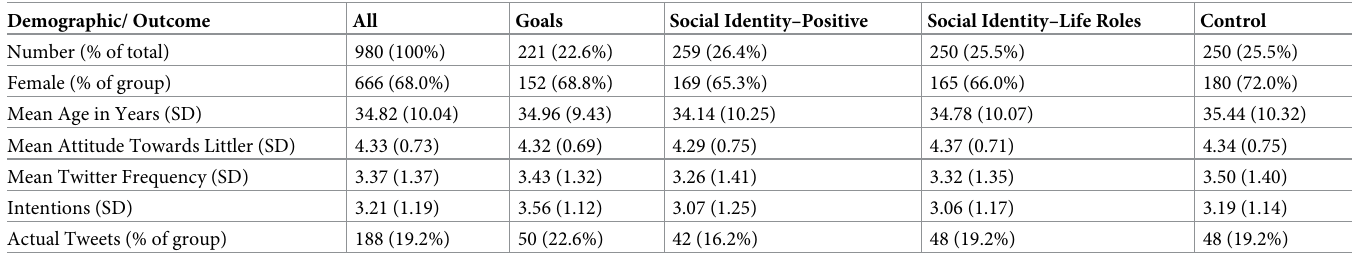
Table 4. Trial 1: Participant Demographics/Outcome: Evaluative Trial 1 about behavioral intentions. Demographic/ Outcome All Goals Social Identity–Positive Social Identity–Life Roles Control Number (% of total) 980